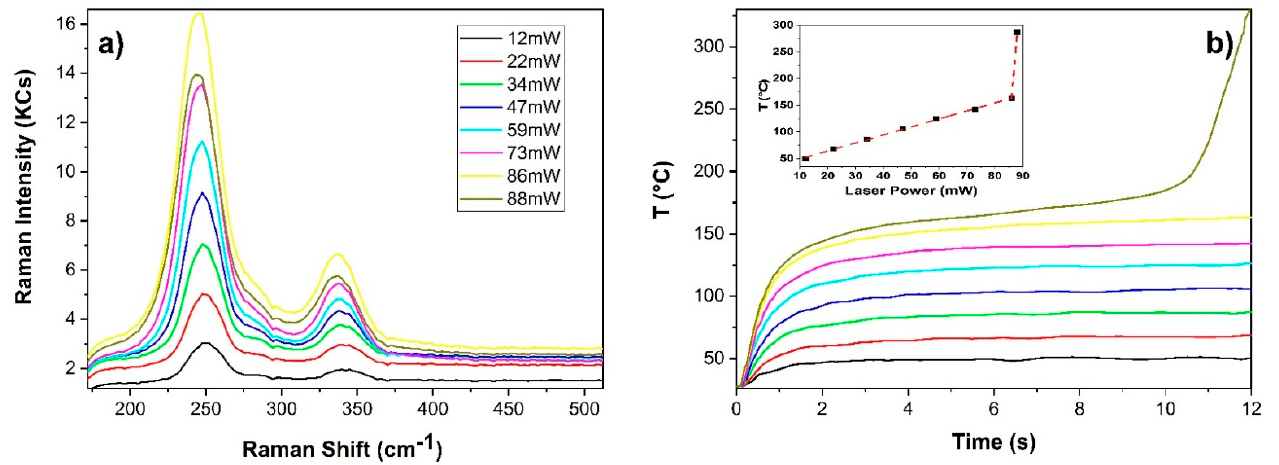
Figure 5. Raman spectra ( a ) obtained for cinnabar powder at different laser power and corresponding temperature temporal profiles ( b ). In the inset, the trend of temperature measured at 11.6 s as function of the laser power.